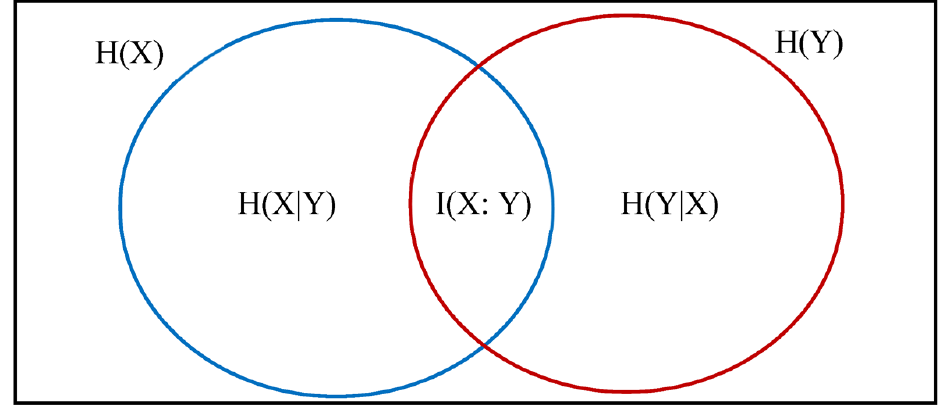
Figure 5. Relationship between information coefficient and entropy.